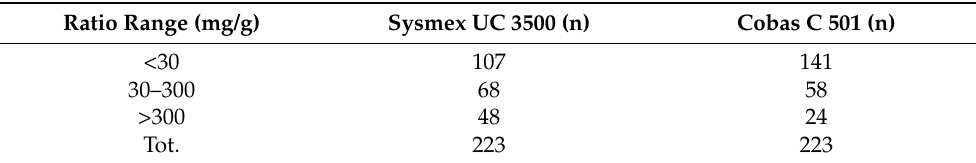
Table 3. Comparison of 223 samples of ACR calculated using the semi-quantitative and quantitative methods. Sysmex UC 3500 was not able to detect ACR in 26 of the 249 analyzed samples. Ratio Range (mg/g) Sysmex UC 3500 (n) Cobas C 501 (n) <30 107 141 30–300 68 58 >300 48 24 Tot. 223 223